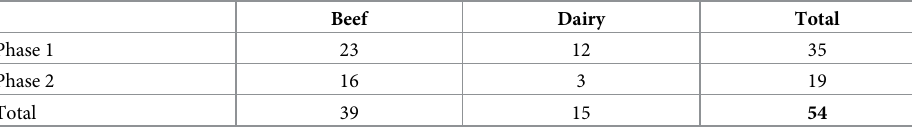
Table 1. Total cattle farm operators interviewed.